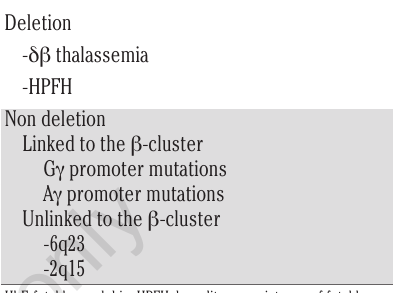
Table 1. Genetic conditions with increased HbF in adult life.